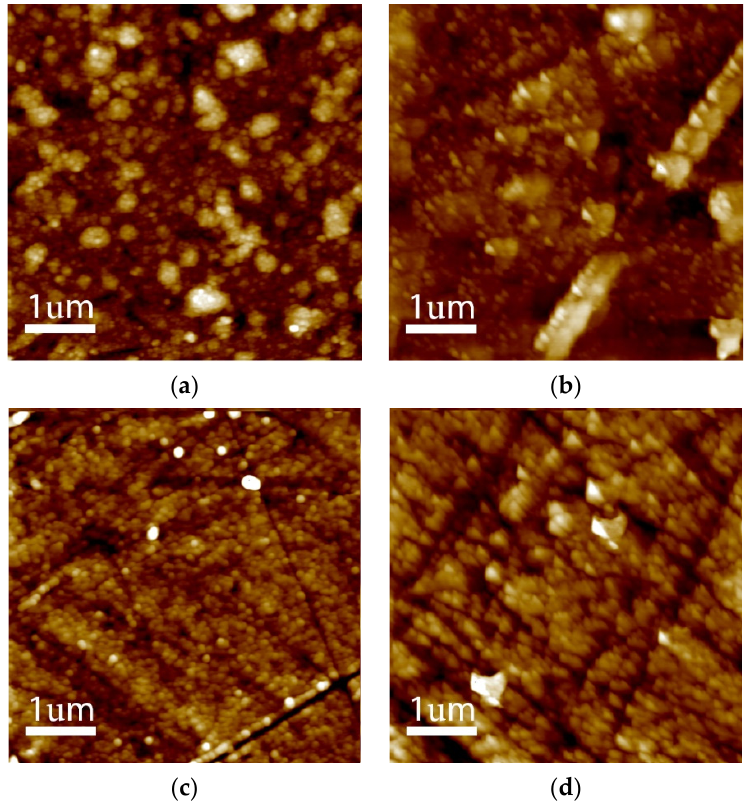
Figure 2. AFM 2D topography of ( a ) 4% (UNCD-4), ( b ) 5% (UNCD-5), ( c ) 6% (UNCD-6), and ( d ) 7% (UNCD-7).